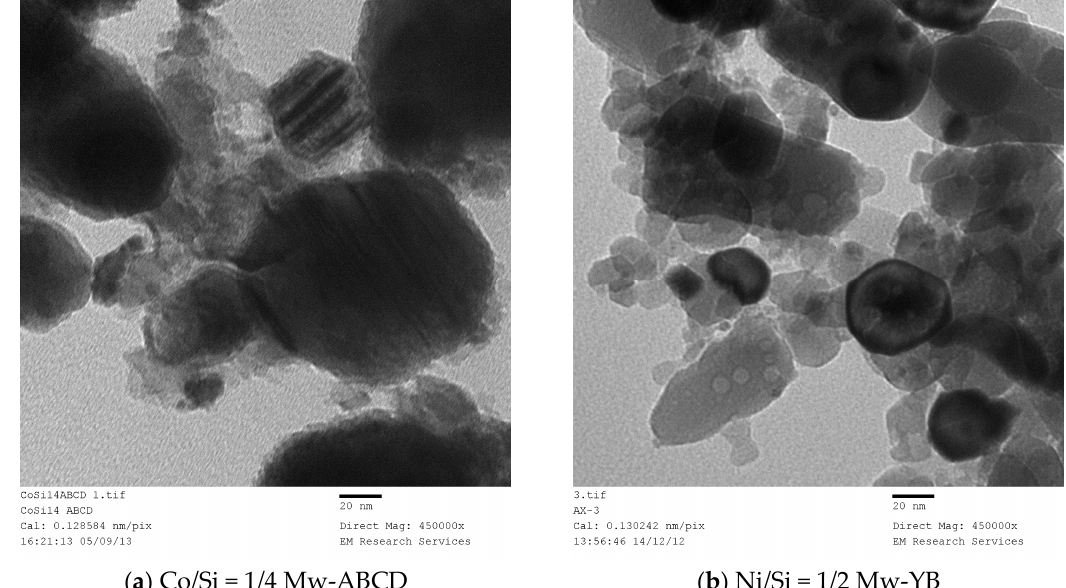
Figure 24. TEM images of Co/Si and Ni/Si catalysts with varying compositions and processing history showing the presence of planar ( a ) or spherical layering ( b ) of the catalyst.